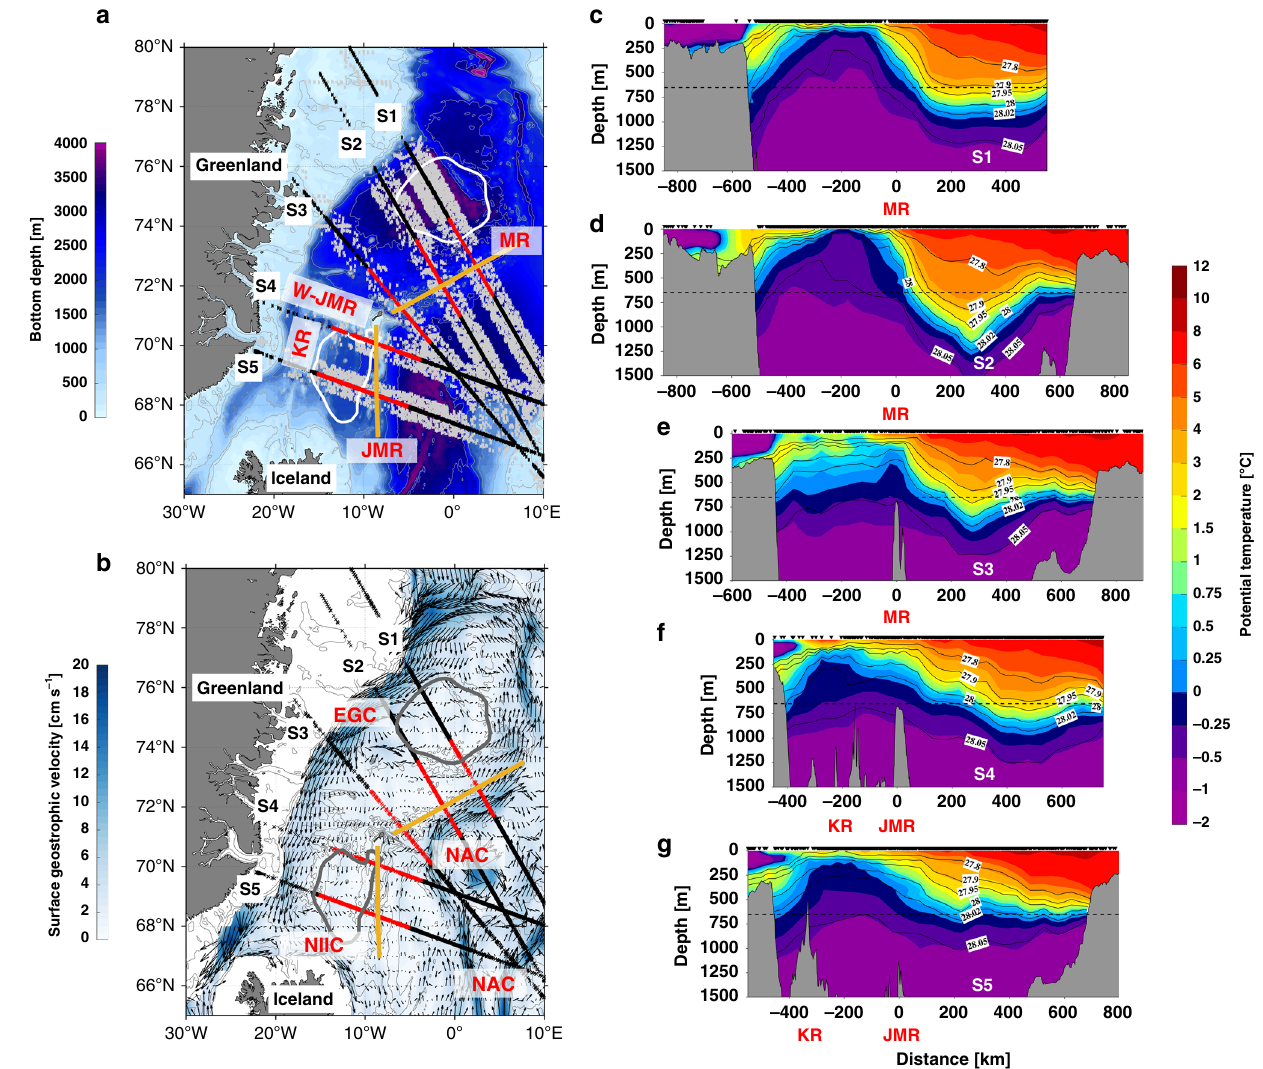
Fig. 3 Cross-pathway sections of potential temperature and potential density. a Locations of the fi ve composite sections (S1 – S5) centered on the Mohn Ridge (MR) and Jan Mayen Ridge (JMR) (yellow lines, see Fig. 2 for all ridge names). The original and projected locations of hydrographic pro fi les used in each section are indicated by gray and black crosses, respectively. The red crosses denote the segment of the section used for calculating the absolute geostrophic velocity in Fig. 4. The Greenland Sea and Iceland Sea gyres are outlined by the white contours. b The long-term mean (2005-2015) surface geostrophic velocity from the gridded satellite altimeter product. The two branches of the Norwegian Atlantic Current (NAC), the East Greenland Current (EGC), and the North Icelandic Irminger Current (NIIC) are labeled. The color indicates speed [cm s − 1 ]. c – g Cross-sections of potential temperature [°C] in color, overlain by potential density contours [kg m − 3 ]. The origin of the x axis in S1-S3 and in S4-S5 are the locations of the Mohn Ridge and Jan Mayen Ridge, respectively. The horizontal dashed back line indicates the sill depth of Denmark Strait (650 and strengthens by section S3. This branch passes through the